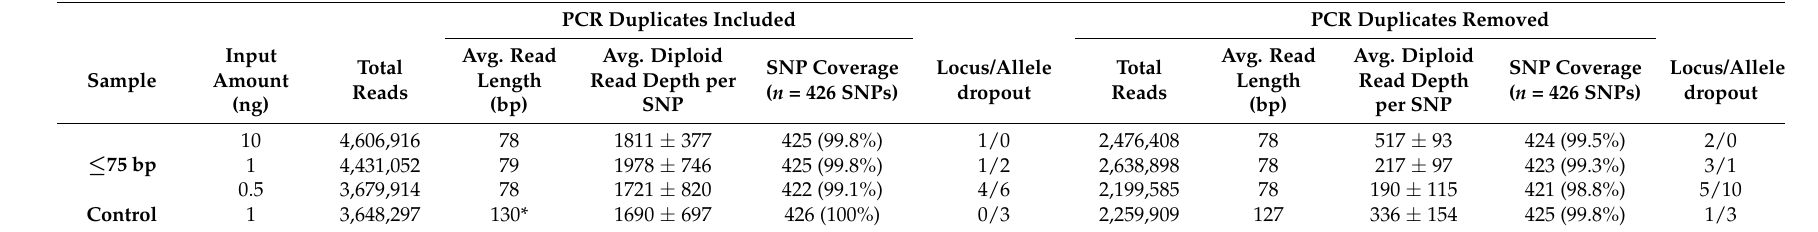
Figure 3. Average diploid read depth per SNP from the size selection study. Mechanically fragmented NA24129 control DNA sample was size selected at ≤ 75 bp and tested at 10 ng, 1 ng, and 0.5 ng. The diploid reads of each of the 426 SNPs ( y -axis) was plotted in order of their SNP number (see Table S1 for details of SNPs corresponding to each number ( x -axis)). All samples exhibited >99% coverage of 426 nuclear SNPs at >10 × allelic read depth per SNP. Table 3. Sequencing statistics for nuclear SNPs size selection study.